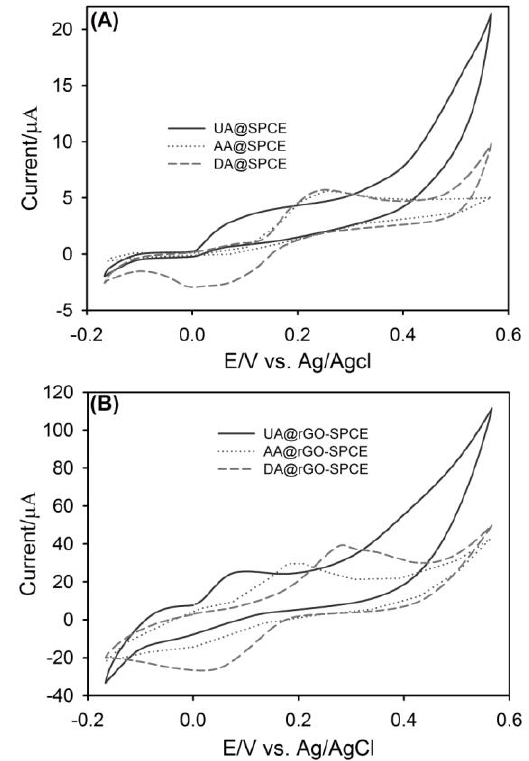
Figure 2. Cyclic voltammograms of ternary mixtures of UA (0.5 mM), AA (5.0 mM) and DA (0.5 mM) in BR buffer (pH 7.0) at: ( A ) SPCE; and ( B ) rGO-SPCE. Scan rate, 50 mV·s −1 .